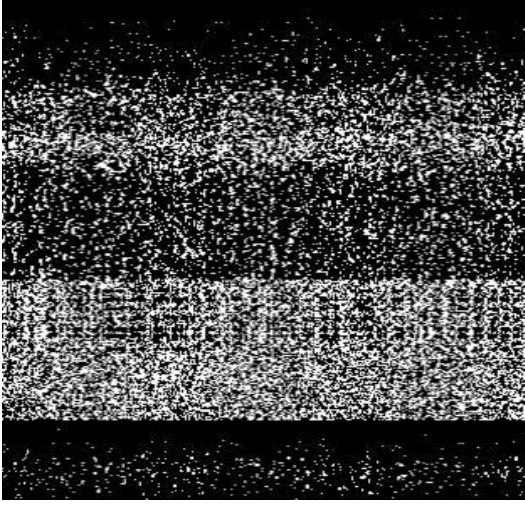
Figure 4. Impulse noise extracted from the image shown in Figure 3.